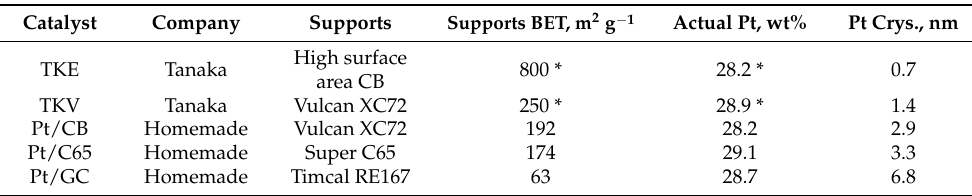
Table 2. Physical characteristics of both homemade and commercial